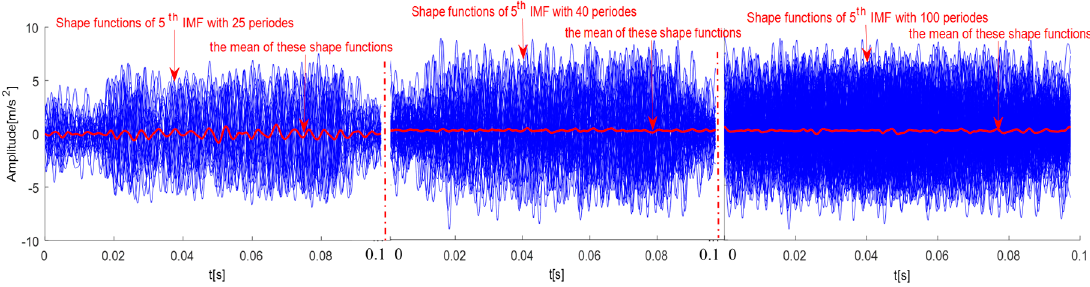
Figure 4. Phase lock in average of one IMF for axle bearing vibration signals.